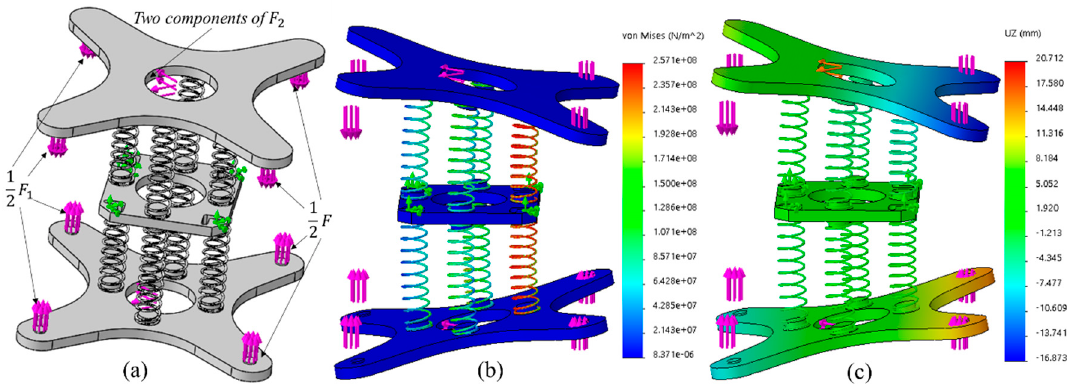
Figure 9. ( a ) Load application. ( b ) The stress distribution on the module element during bending simulation. ( c ) Displace- ment and deformation.